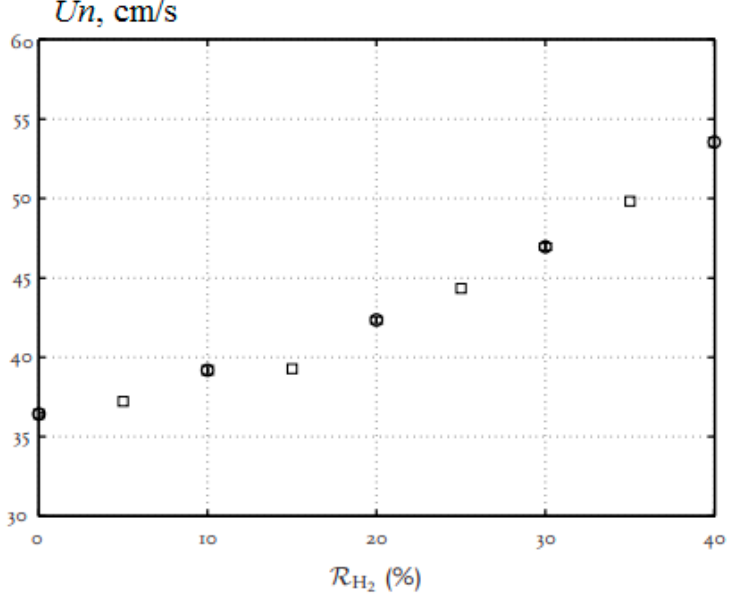
Figure 4. Dependence of the normal flame velocity Un of hydrogen–methane–air mixtures on the equivalence ratio φ under normal conditions. The hydrogen concentration: о —0%; ▽ —10%; □ — 20%; x—30%; +—40% (Adapted from ref. [17]). Thus, an increase in the hydrogen concentration in the range up to 40% leads to an almost linear increase in the normal flame velocity (Figure 5).